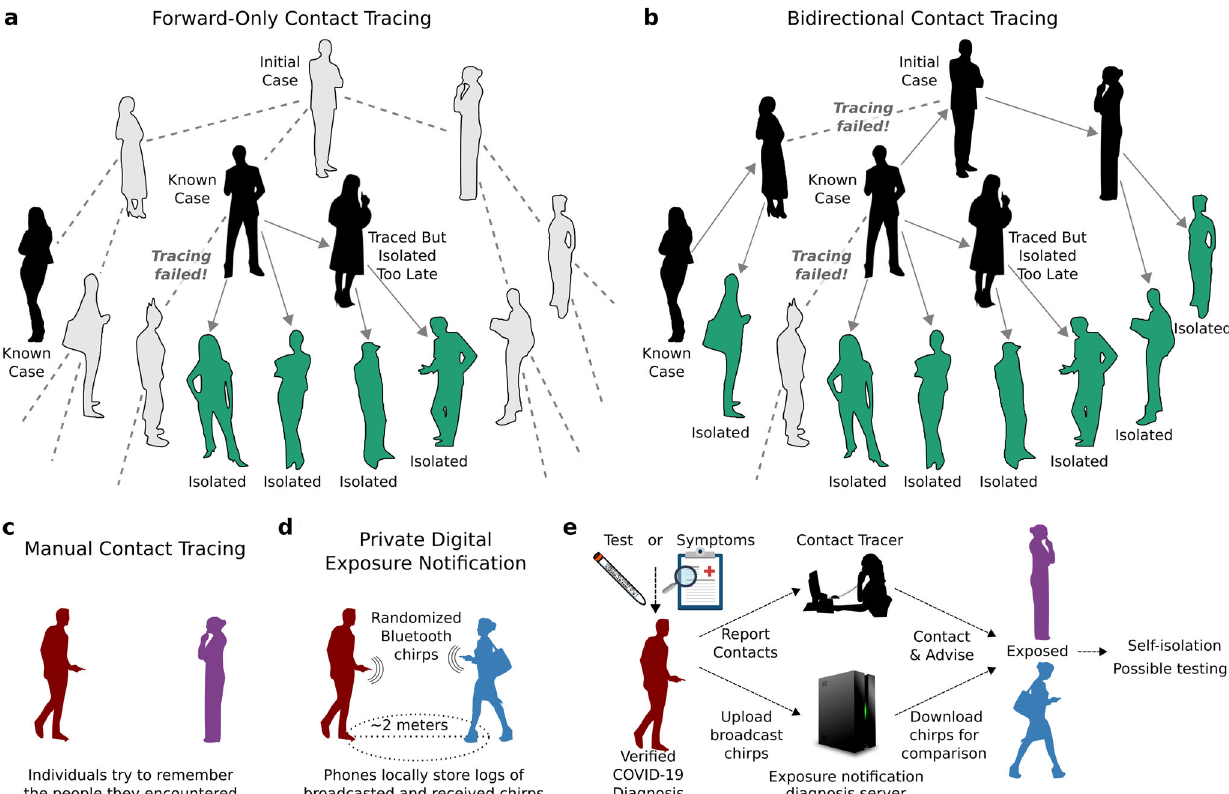
Fig. 1 Forward-only and bidirectional contact tracing and digital exposure noti fi cation. a Notifying people exposed to known cases (black) and isolating them (green) can prevent further transmission, but will miss asymptomatic and undiagnosed cases (gray) and descendants. b Bidirectional tracing also noti fi es and tests potential infectors, enabling isolation of additional cases. c Manual contact tracing requires individuals to share recent contacts with health authorities. d In digital exposure noti fi cation, smartphones broadcast rotating pseudorandom “ chirps ” and record those emitted by nearby devices 48 . e Individuals diagnosed with COVID-19 can “ opt-in ” by uploading broadcasted chirps to a diagnosis server 48 . All devices frequently check the server and alert the user if the calculated exposure exceeds a threshold set by the local health authority. In hybrid manual + digital systems, human tracers would seek to identify contacts without